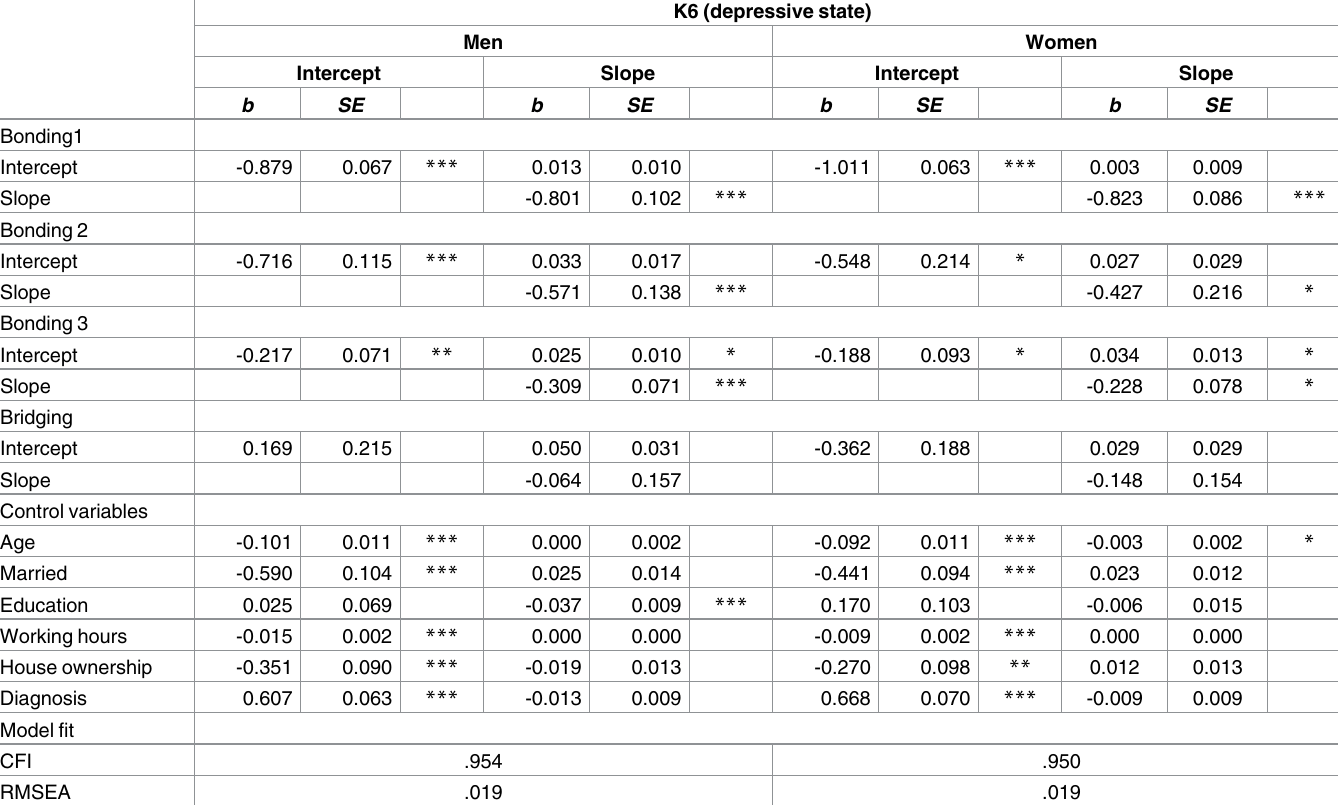
Table 5. Estimated associations between social capital and